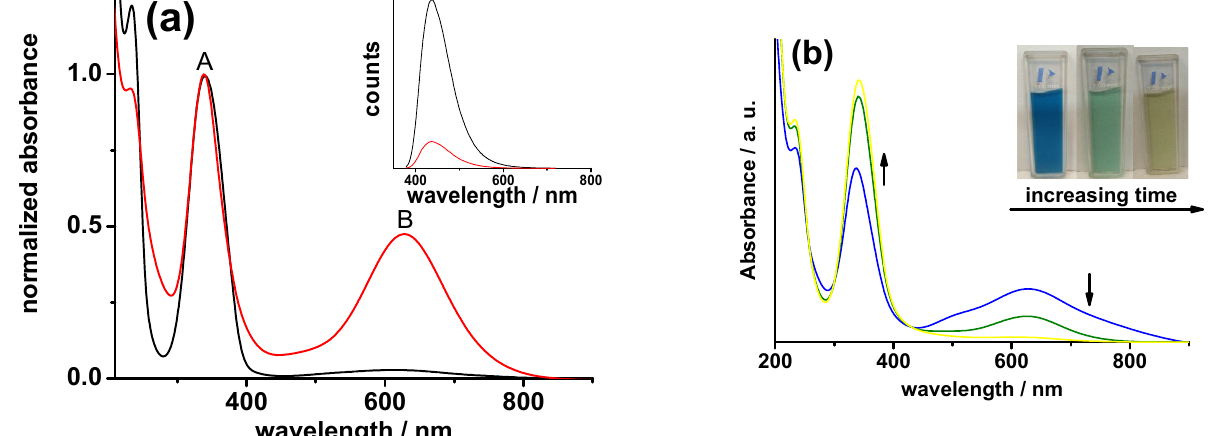
Figure 2. ( a ) Normalized UV–vis absorption spectra of 1 mg mL − 1 water solutions of N-CDs-160-1 (black line) and N-CDs-160-8 (red line); inset: PL spectra at 365 nm excitation of N-CDs-160-1 (black line) and N-CDs-160-8 (red line). ( b ) UV–vis absorption spectra of sample N-CQDs-160-8 upon hydrazine addition at increasing time; inset: photoghaph of sample N-CQDs-160-8 solutions after hydrazine addition at increasing time of reaction (blue oxidized form at t = 0 h, yellow reduced form at t = 70 h, green an intermediate form).